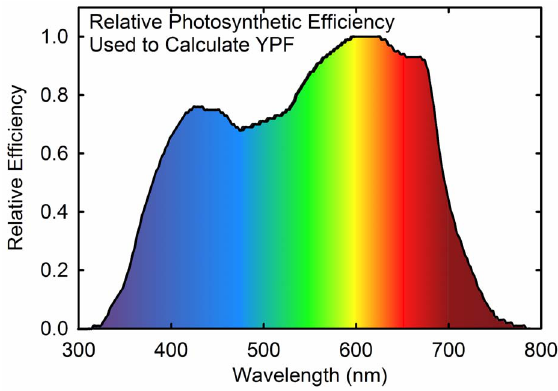
Figure 3. Yield photon flux curve. Effect of wavelength on relative photosynthesis per incident photon for a single leaf in low light (less